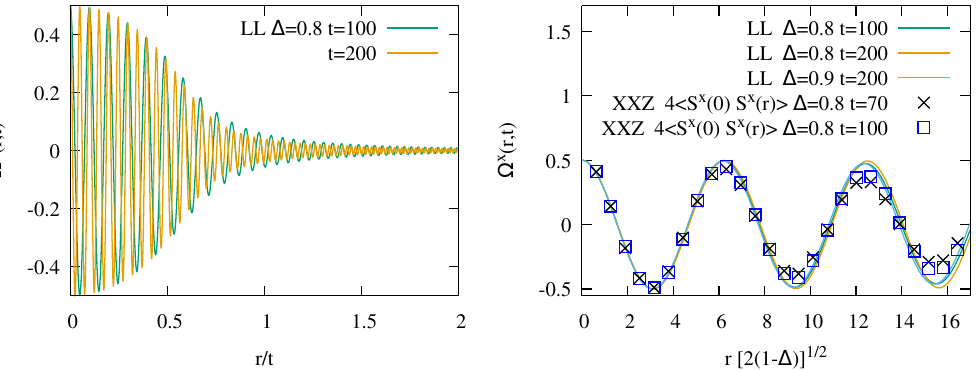
Figure 2: Left panel: Ω x ( r , t ) as a function of the rescaled position r / t for ∆ = 0.8 for different times t = 100 and t = 200. The envelope of the oscillations is approxi- mately the same at t = 100 and t = 200 (this follows from the fact that Ω z scales as r / t , see Fig. 3). Right panel: when plotted as a function of r the period of the first oscillations turns out to be almost independent of time and ∆ , and is numerically close to 2 π . This can be understood using the asymptotic solution discussed in Sec. 4.1, which predicts that | ϕ ζ | = 1. The crosses are spin-spin correla- tions in the XXZ chain at ∆ = 0.8, t = 70 and t = 100. See Sec. 7.2 for the relation between spin-spin correlations in the quantum chain and the in-plane component of the LL